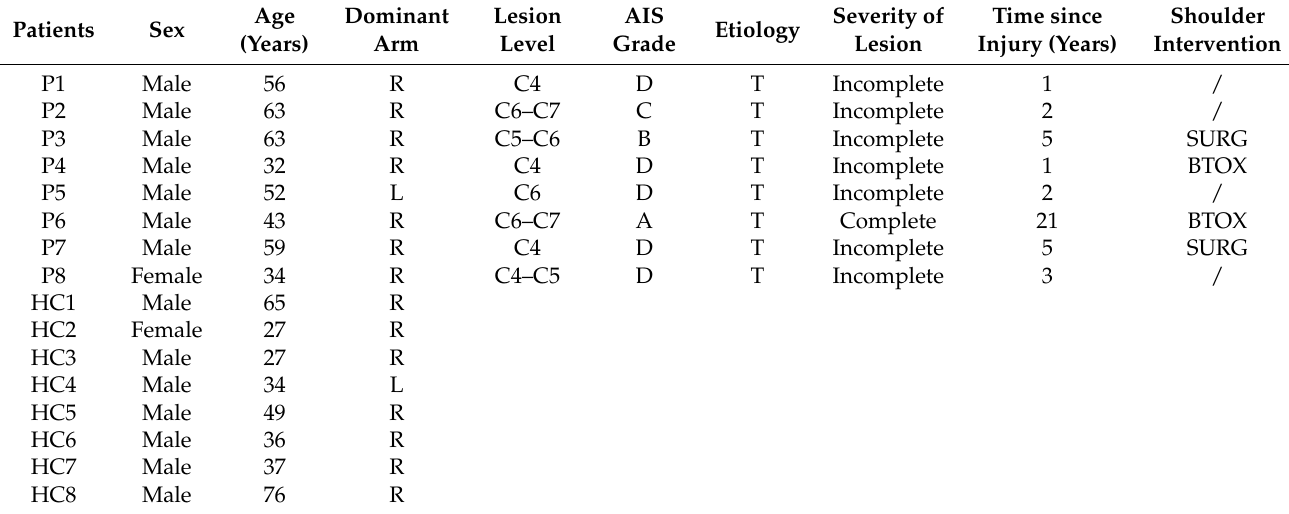
Table 2. Characteristics of the participants to the experimental tests. Abbreviations used: P stands for patient; HC stands for healthy control; R stands for Right; L stands for Left; AIS stands for American Spinal Injury Association Impairment Scale; T stands for traumatic; SURG stands for Surgery Intervention; BTOX stands for Botulin Toxin